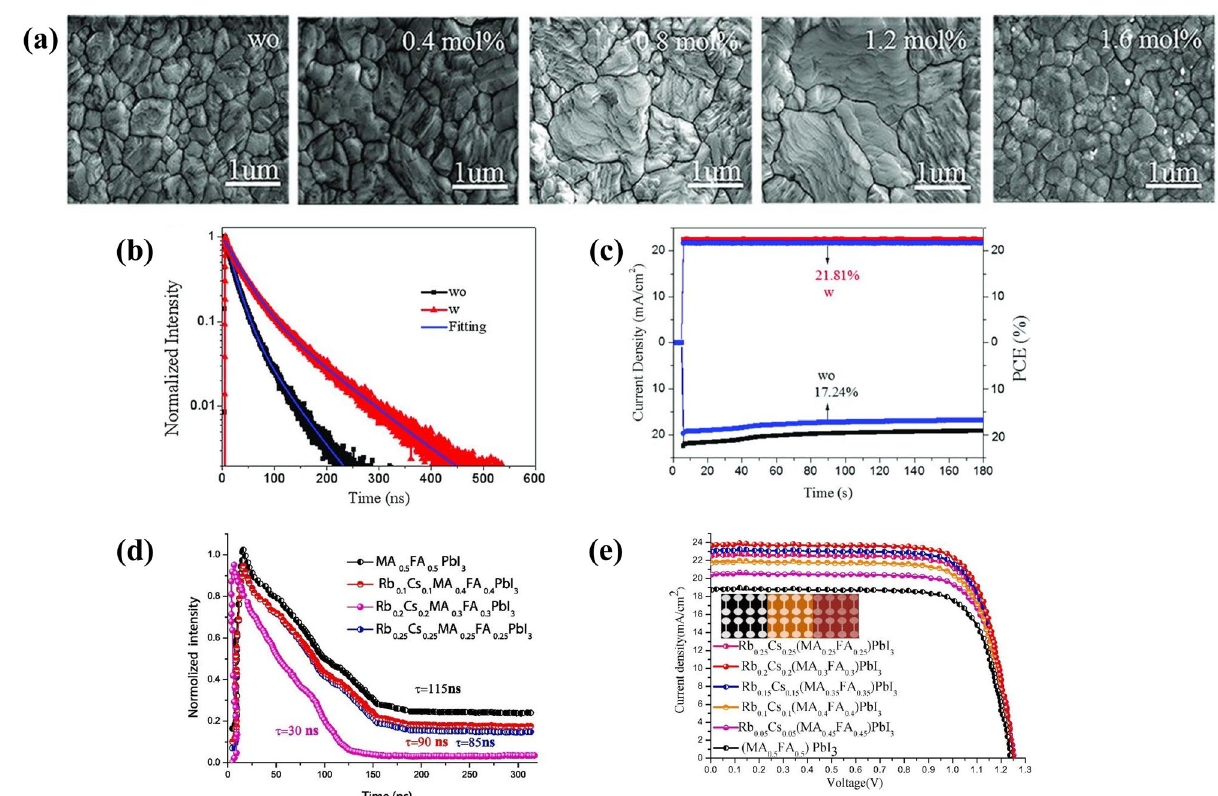
ref. [60], copyright 2019, WILEY–VCH. d Time ‐ resolved PL e and photovoltaic performance of perovskite thin films doped with dif- ferent proportion of Rb+ and Cs+ ions. Adapted with permission from ref.[61], copyright 2020,